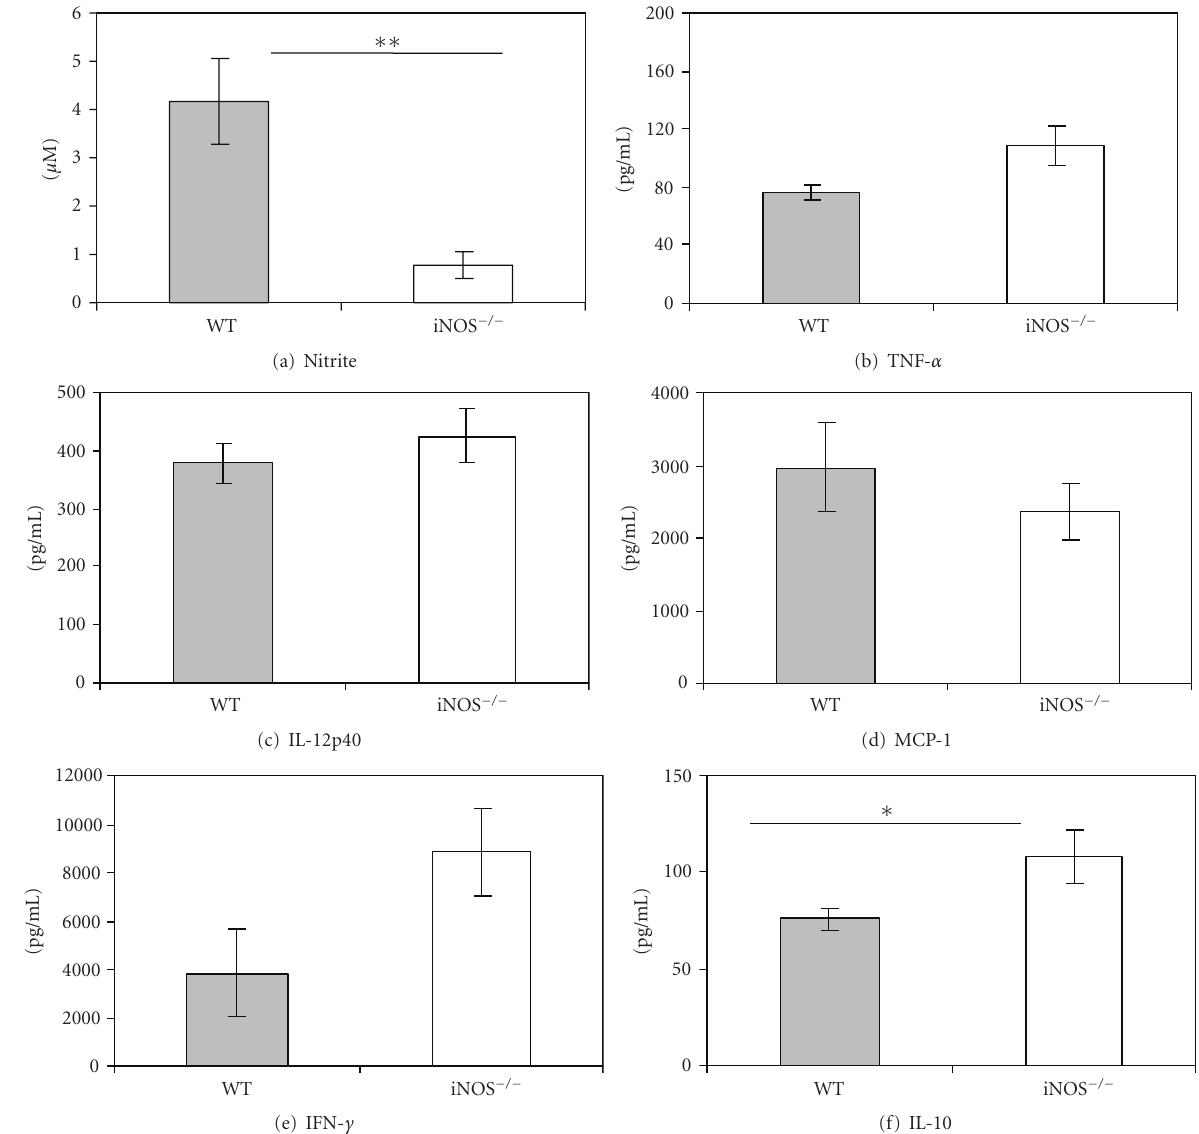
Figure 2: iNOS − / − mice infected with 10 3 T. congolense produce no detectable nitric oxide but more IL-10 than infected wild-type (WT) mice. Mice were infected with 10 3 T. congolense . On day 6 postinfection, spleen cells were cultured at an optimal cell density (5 × 10 6 /mL) for 48 hours. Cytokines in culture supernatants were measured by ELISA, nitrite by the Griess reaction. ∗ P < . 05, ∗∗ P < .